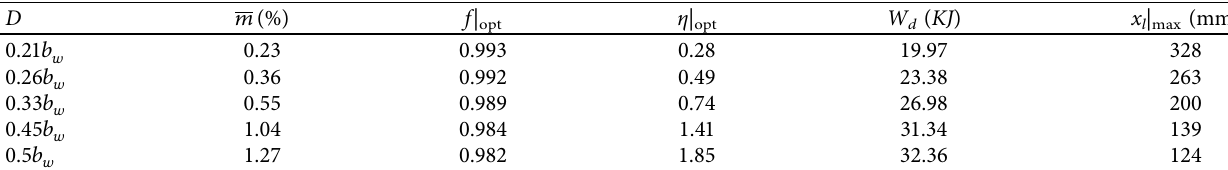
Table 3: Optimal 6-column TLWD parameters under various column diameters D